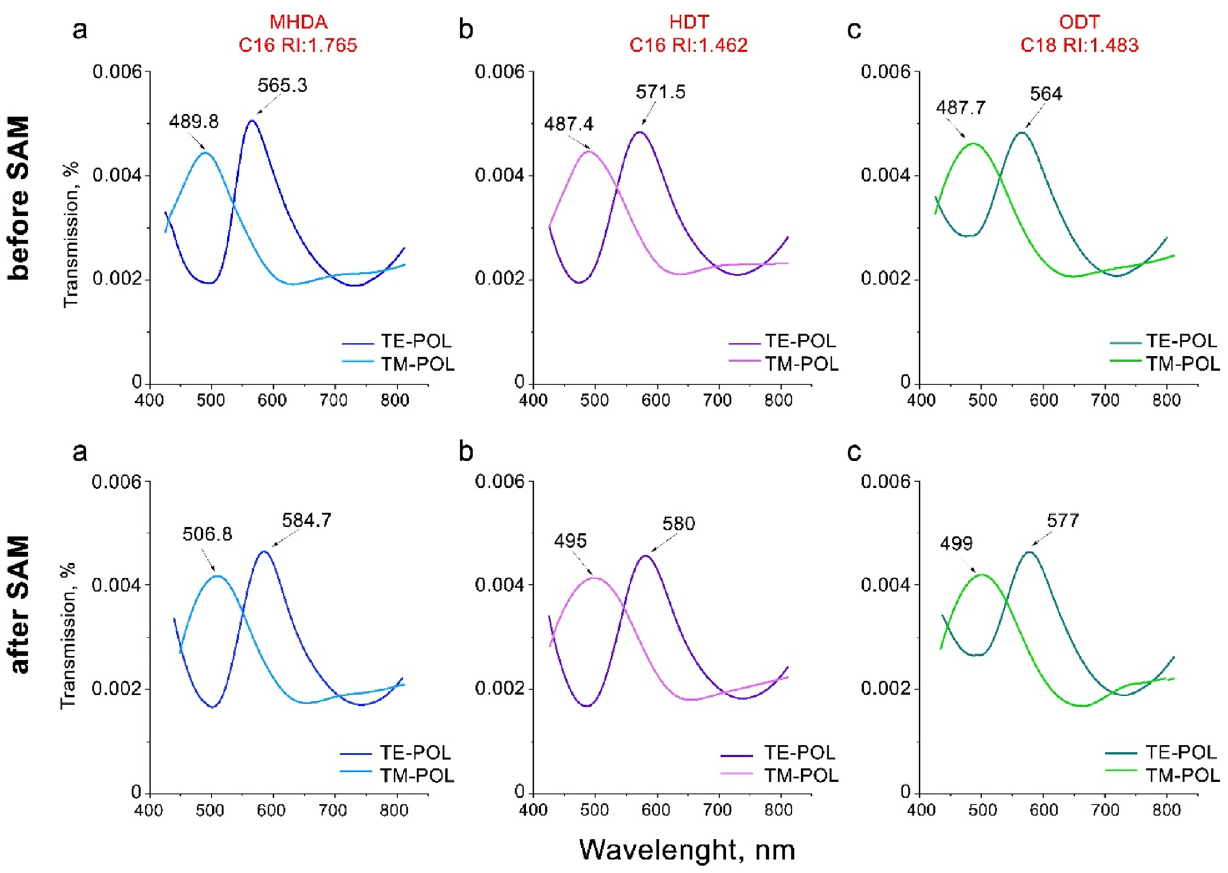
Figure 6. Transmission spectra taken in air for three devices: top row—before and bottom row—after deposition of MHDA, HDT and ODT SAMs respectively.